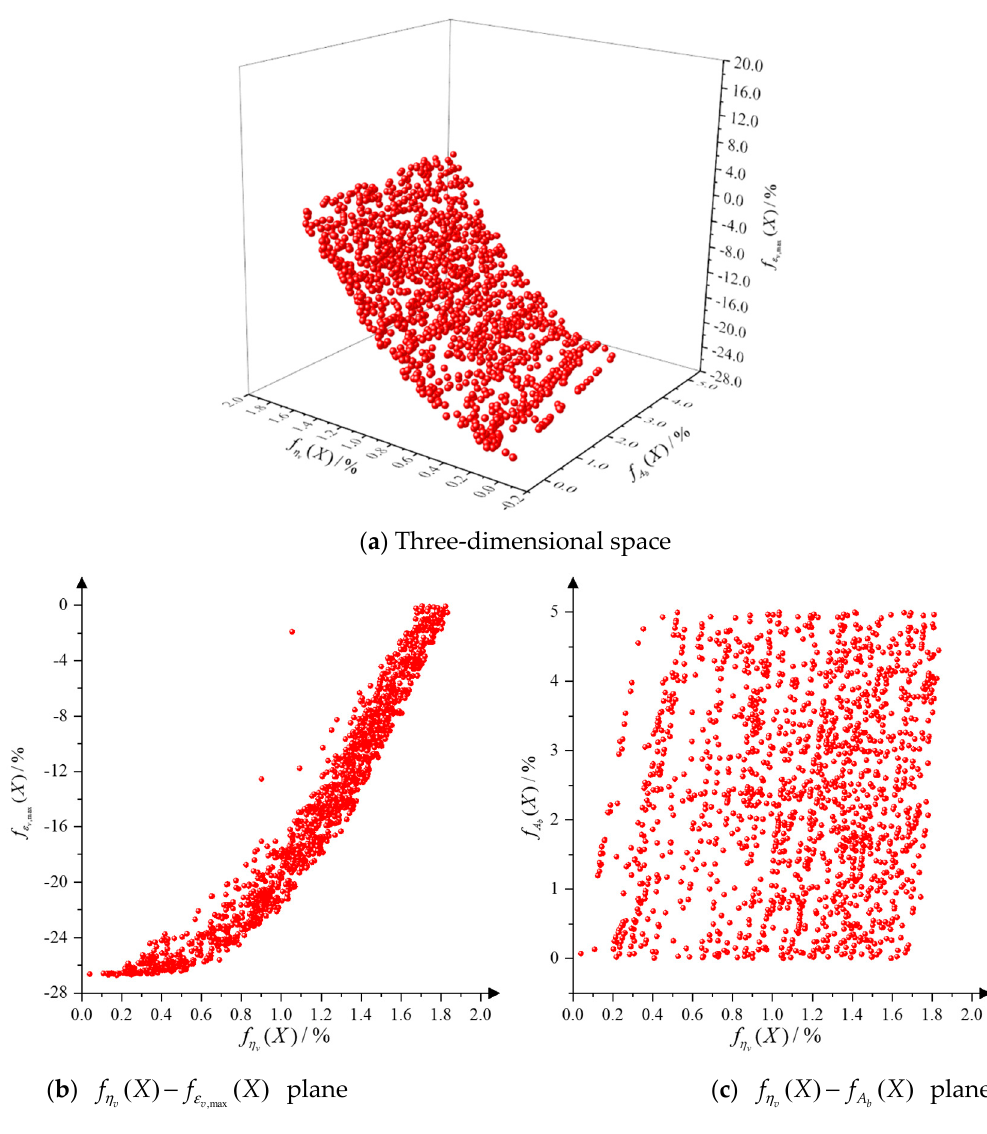
Figure 15. Schematic diagram of the distribution of Pareto optimal solutions.